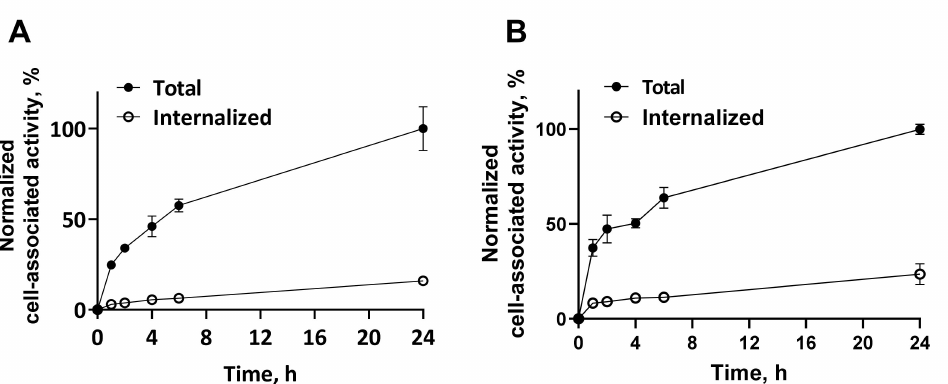
Figure 5. Normalized cellular processing of [ 111 In]In-NODAGA-(HE) 3 -Z IGF-1R:4551 after binding to IGF-1R-expressing DU145 ( A ) and SKOV3 ( B ) cells in vitro. The data are presented as the average ± standard deviation of three